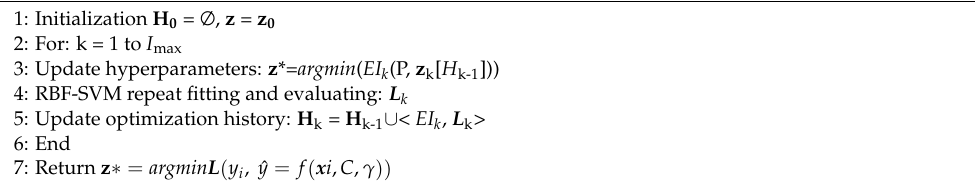
Algorithm 1 The pseudo-code of tree-structured Parzen estimator algorithms (for